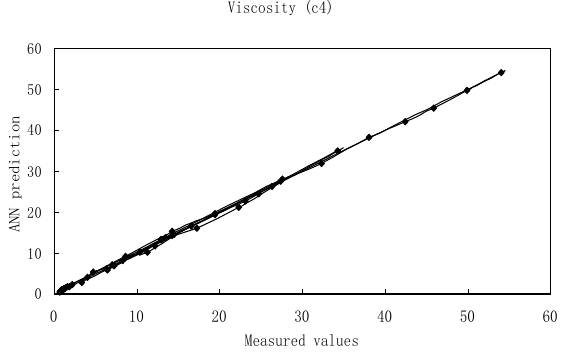
Fig. 5.1: Evaluation of ANN performance; A scatter plot of typically measured experimental viscosity data (mPas) against the ANN model for unseen viscosity data for [C 4 -mim][NTf 2 ]- ethanol binary mixtures